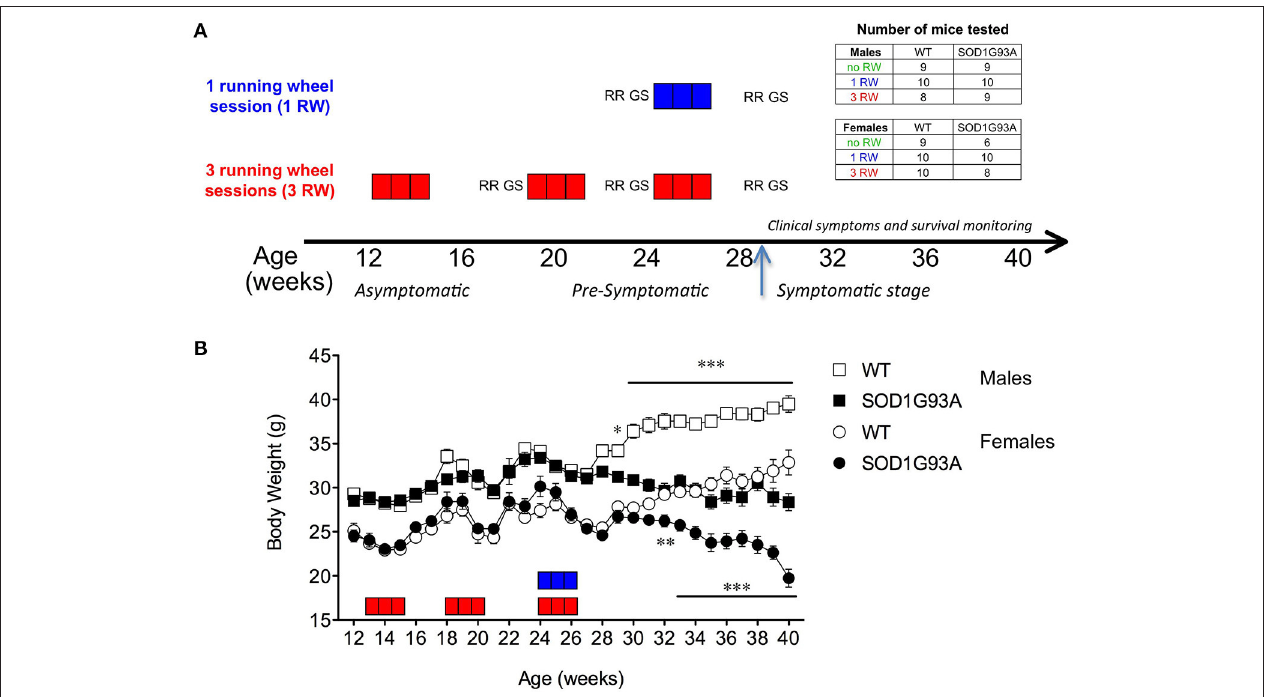
FIGURE 1 | Experimental design and body weight. (A) Experimental design: Each square box represents 1 week of running wheel (RW) exposure: in blue, group 1 RW; in red, group 3 RW. Each three squares/weeks is one session. RR, Rotarod test; GS, grip strength test. Arrow indicates appearance of disease symptoms and beginning of health and survival daily monitoring. Inset: Tables indicate the number of mice tested in each experimental group. (B) Body weight curve in grams of male and female SOD1G93A low-copy and WT littermates across experimental window (12–40 weeks of age). Number of animals varied along the study. Age 12–18 weeks (3 RW only): n = 8–10 per sex/genotype; Age 19–30 weeks: n = 23–29 per sex/genotype; Age 30–40 weeks: WT n = 26–29 per sex, SOD1G93A n = 6–20 per sex depending on survival. Asterisks indicate statistically significant differences between WT and transgenic mice in each sex group. * P < 0.05, ** P < 0.01, *** P <